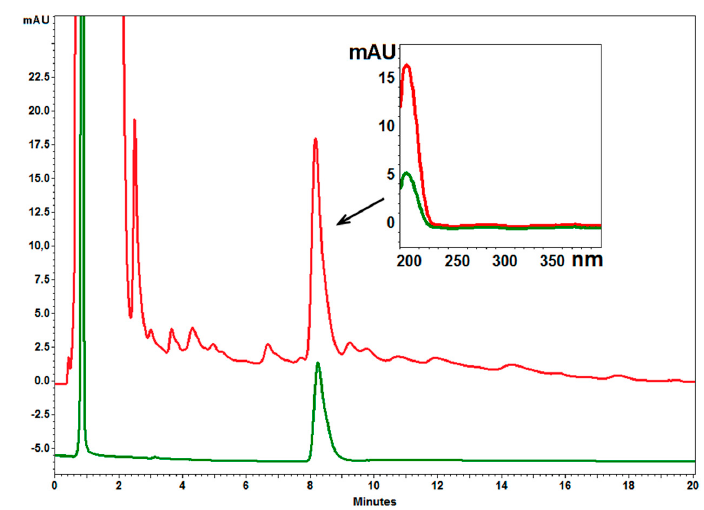
Figure 3. Example chromatograms of birch bark extract (red line) and reference compound—lupeol (green line). Over the chromatograms the spectrum of identified and reference compound. RP18e Chromolith, acetonitrile–water (95:5 v / v ), flow rate 2 mL/min, at 25 ◦